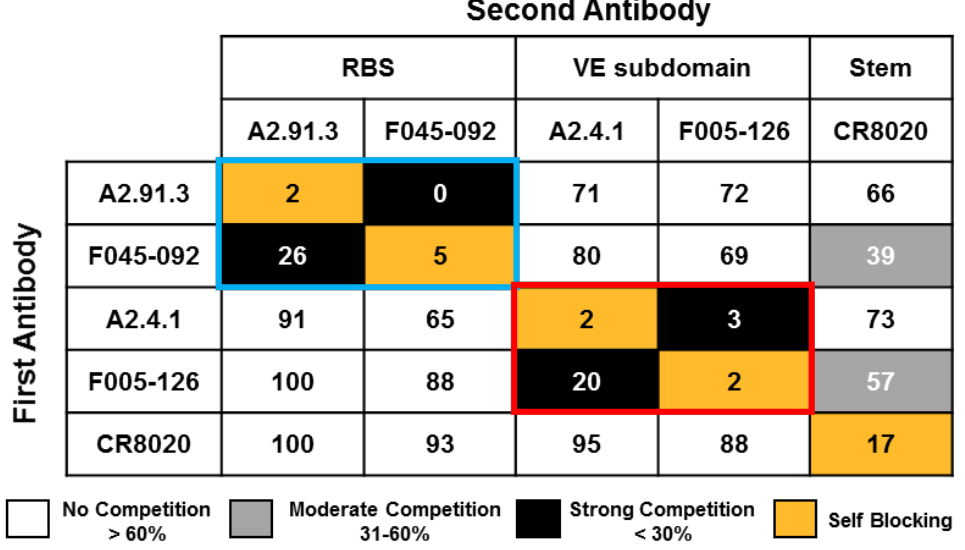
Figure 1. Transmission electron microscopy (TEM) of hemagglutinin (HA) nanoparticles with Fab binding. ( A ) Negative-stain TEM 2D class average images of A/Hong Kong/4801/2014 HA nanoparticles shown with one to three HA trimers per nanoparticle as previously reported [22]. A/Hong Kong/4801/2014 HA nanoparticles were incubated with 1:10 molar ratio of A2.91.3 ( B ) or A2.4.1 ( C ) Fabs prior to imaging. Individual particles were selected using automated and manual picking for 2D class averaging. Fab domains are circled in blue and the detergent core is circled in green.